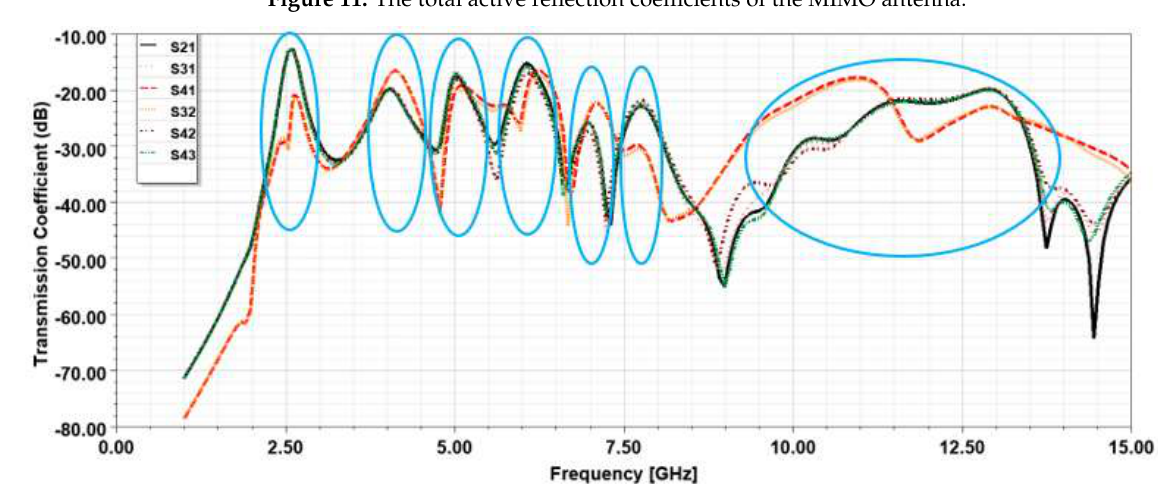
Figure 11. The transmission coefficients between all four ports. Figure 11. The total active reflection coefficients of the MIMO antenna.